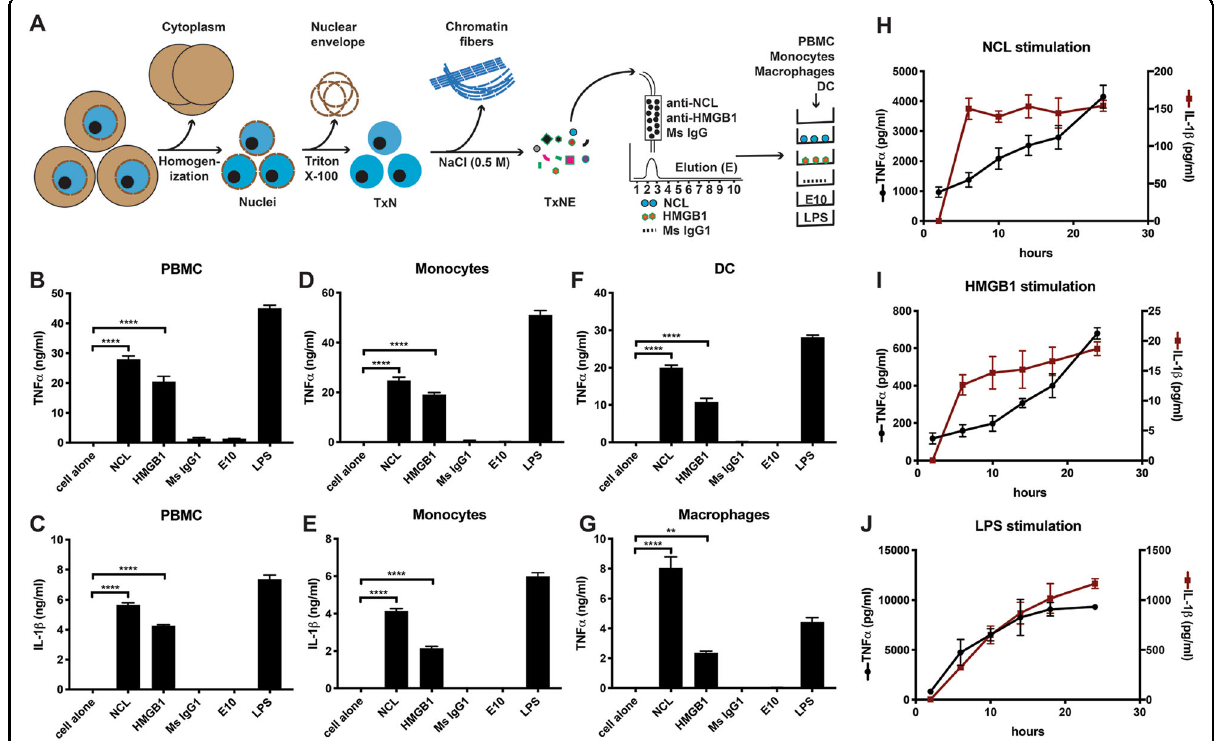
Fig. 1 NCL activates PBMC, monocytes, macrophages, and dendritic cells (DC). A NCL and HMGB1 isolation and leukocyte stimulation. HeLa cell nuclei were fi rst extracted in 1% (v/v) Triton X-100 (TxN) and proteins were extracted from TxN using 0.5 M NaCl as TxNE from which NCL and HMGB1 were af fi nity-puri fi ed. As a control, TxNE was also applied on immobilized mouse IgG1 (Ms IgG1). Elution from each column (fractions 2 and 3) were pooled. Fraction 10 lacked detectable proteins and were combined as another control (E10). Pooled NCL, HMGB1 and controls were coated on the plate to stimulate PBMC, monocytes, macrophages and DC. LPS (0.5 μ g/ml for DC and macrophages and 10 ng/ml for PBMC and monocytes) was used as a positive control. B , C TNF α and IL-1 β induction from PBMC. D , E TNF α and IL-1 β induction from monocytes. F , G TNF α induction